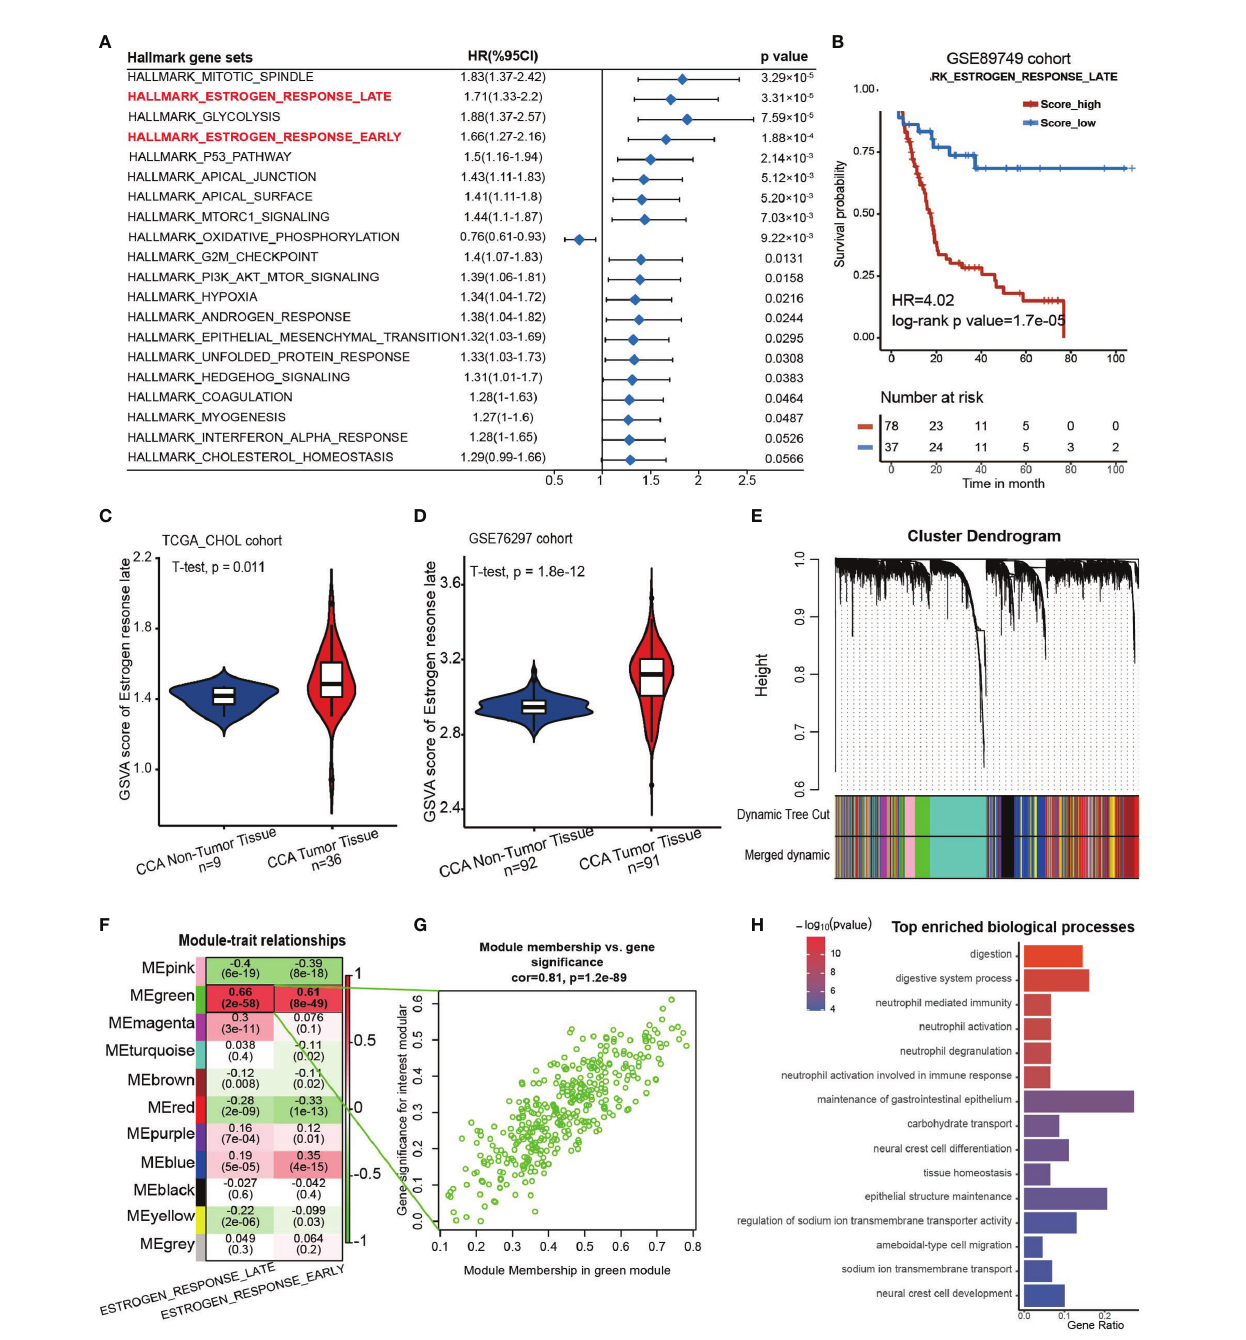
FIGURE 1 | An estrogen response-related gene set was identi fi ed. (A) Forest plot showing the prognostic value of the GSVA score of the top 20 hallmark gene sets in the GSE89749 cohort. The horizontal coordinates represent the univariate regression coef fi cient of the normalized GSVA score of each hallmark of cancer, and the horizontal line represents the 95% con fi dence interval of the univariate regression coef fi cient. (B) Kaplan – Meier curves for overall survival of the patients with high or low GSVA scores of “ Estrogen response late ” in the GSE89749 cohort. Score_low, n = 37; Score_high, n = 78. HR=4.02, Log-rank test, p value = 1.7×10 -5 . (C, D) Violin plots showing the GSVA score of “ HALLLMARK_ESTROGEN_RESPONSE_LATE ” in CCA tumoral and non-tumoral tissues in TCGA_CHOL cohort and GSE76297 cohort. (E) Weighted gene coexpression network analysis (WGCNA) was performed with an expression matrix of 462 samples in the meta cohort to construct a scale-free coexpression network. The cluster dendrogram shows the clustering of genes into gene modules. (F) Eleven gene modules were generated, and a green module exhibited the highest correlation with the GSVA score of “ Estrogen response late ” (Spearman correlation test, r= 0.9, P = 2e-58) and was considered an “ ES-speci fi c module ” . (G) Scatter plot showing the Spearman correlation coef fi cient between the expression of genes in the green module and the eigengene of the green module or the GSVA score of “ Estrogen response late ” . (H) Bar plot showing the top 15 enriched biological processes in the green